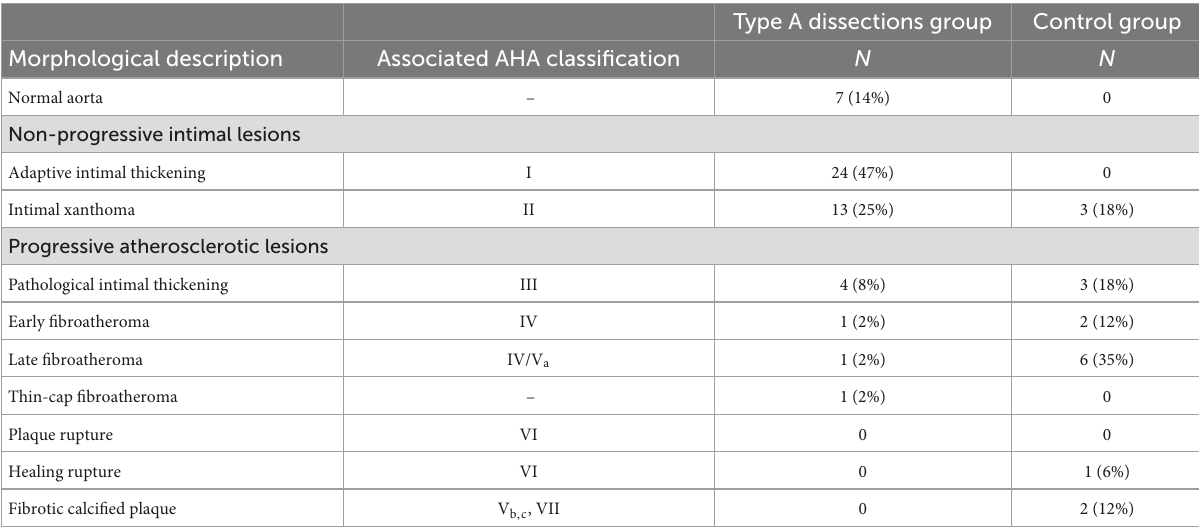
TABLE 2 Atherosclerotic lesions in control